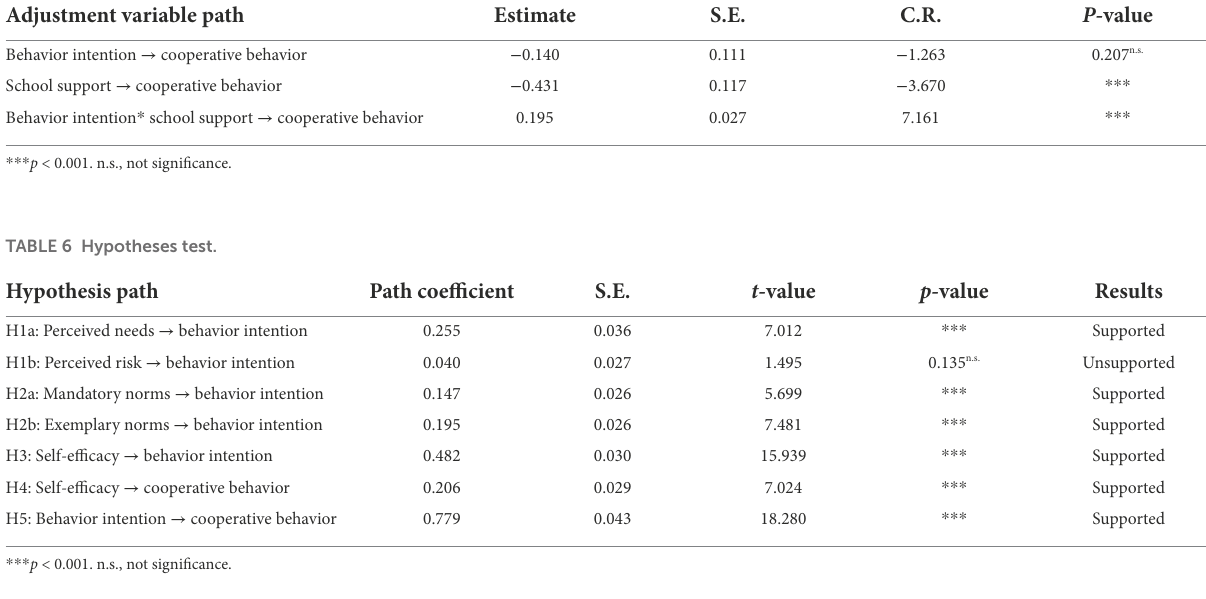
TABLE 5 Moderation variable